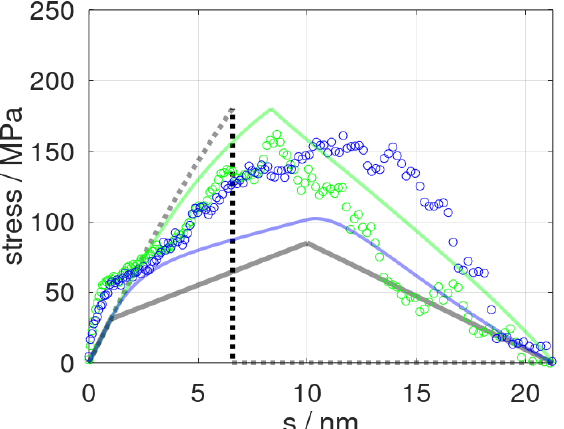
Figure 2. Stress profiles as obtained from molecular dynamic simulations (dots) and predicted stress 𝜎(𝑠) (solid curves) at strain rates of 𝑠̇ = 0.84 and 8.4 m∙s − 1 shown in blue and green colors, respec- tively. In turn, the delimiters for the constitutive model, 𝜎(𝑠; 𝑠̇ = 0) and 𝜎(𝑠; 𝑠̇ → ∞) , are indicated by grey lines and dots, respectively.